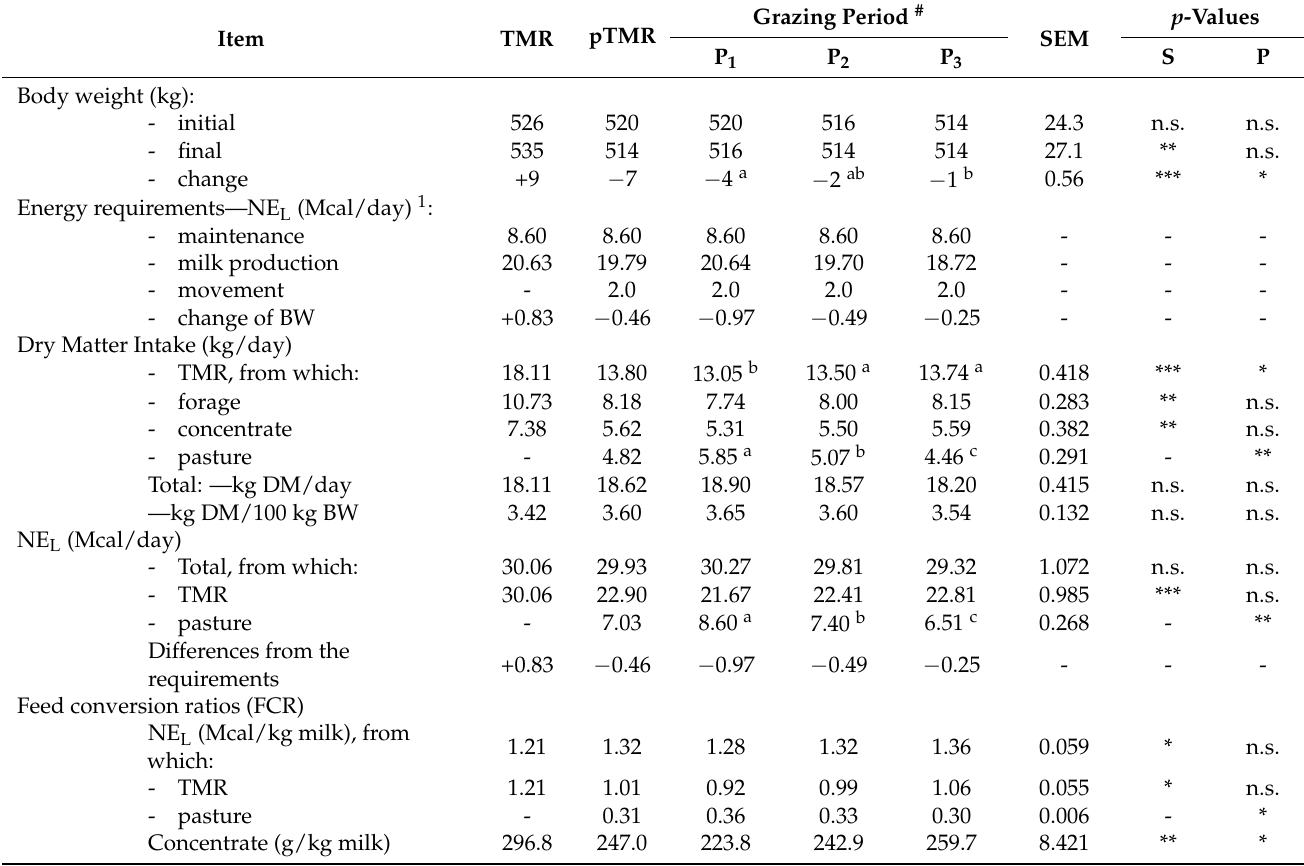
Table 2. Effect of cow feeding system (S: TMR vs. pTMR) and grazing period (P) on body weight (BW) and feed